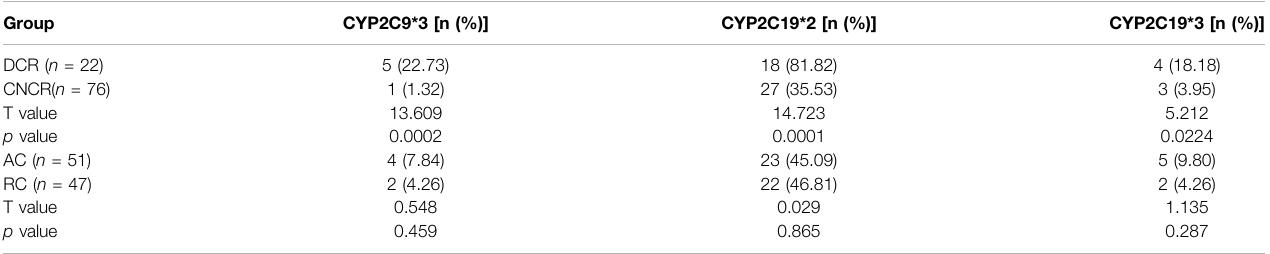
DCR (cid:2) dynamic clopidogrel resistance; CNCR (cid:2) continuous none clopidogrel resistance; AC (cid:2) atorvastatin; RC (cid:2) rosuvastatin